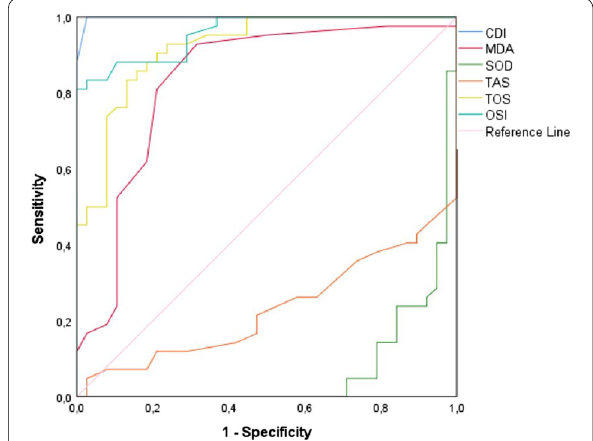
Fig. 1 Receiver operating characteristic (ROC) curve analysis to predict serum oxidative stress biomarkers for diagnosing